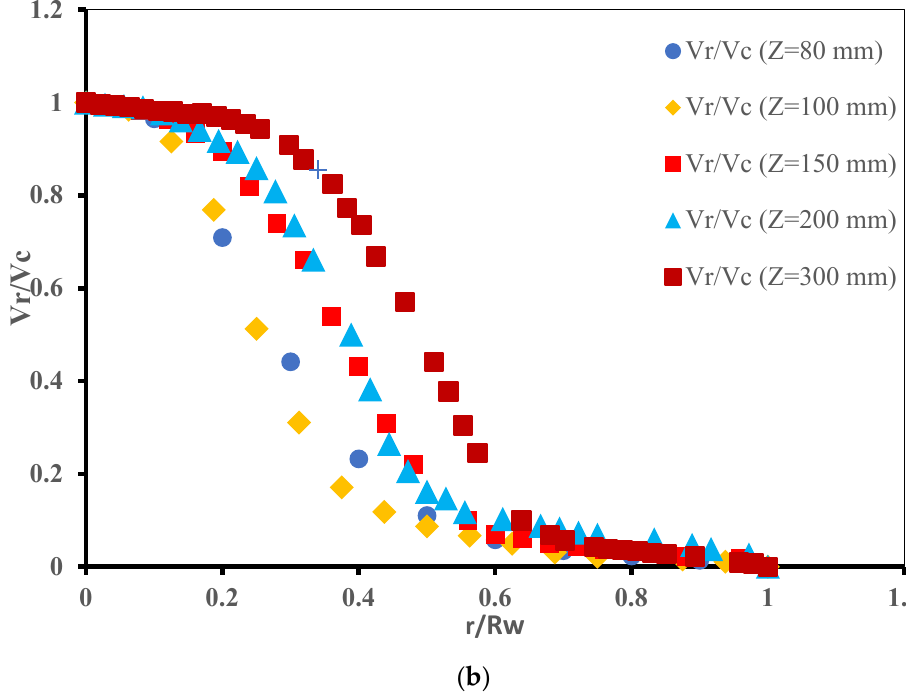
Figure 7. ( a ). Normalized axial velocity compared with normalized radial distance of the water jet at Ge = 295 kg/m 2 s. ( b ) Normalized axial velocity compared with normalized radial distance of the water jet at Ge = 672 kg/m 2 s.